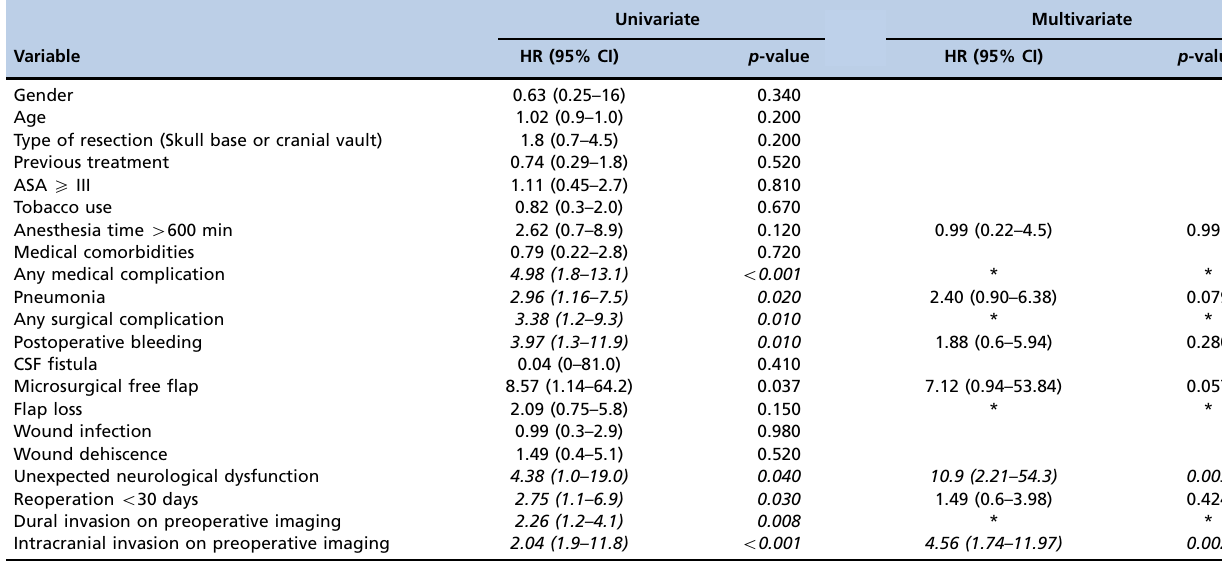
Table 3 - Cox regression analyses identifying the variables associated with perioperative death among patients who underwent extensive craniofacial resection.